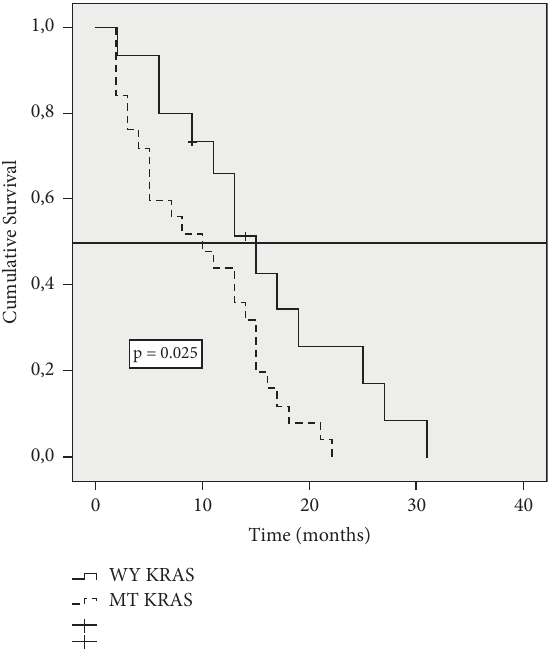
Figure 4: Kaplan–Meier survival function curve in patients with PCI > 20 according to KRAS mutation status. The horizontal bar denotes median